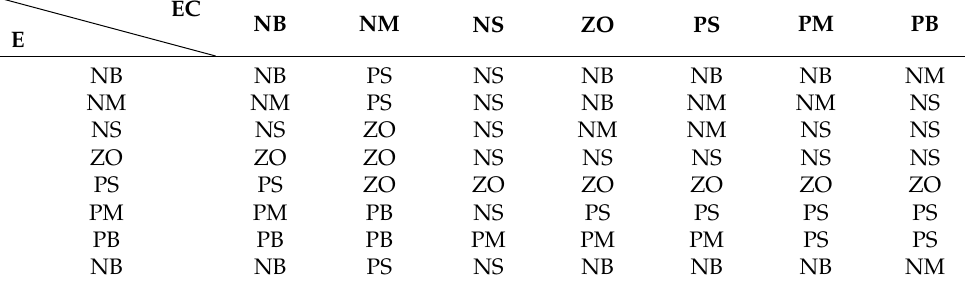
Table 3. Fuzzy rule of ∆ K d